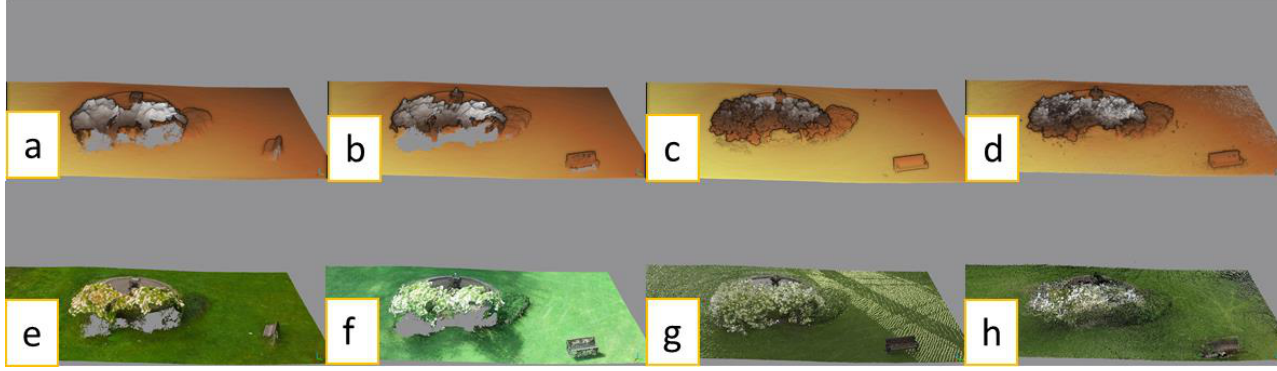
Figure 14. Comparison of point clouds for a blooming shrub. In the top row, the point clouds are colored with the height ramp, and in the bottom row with RGB